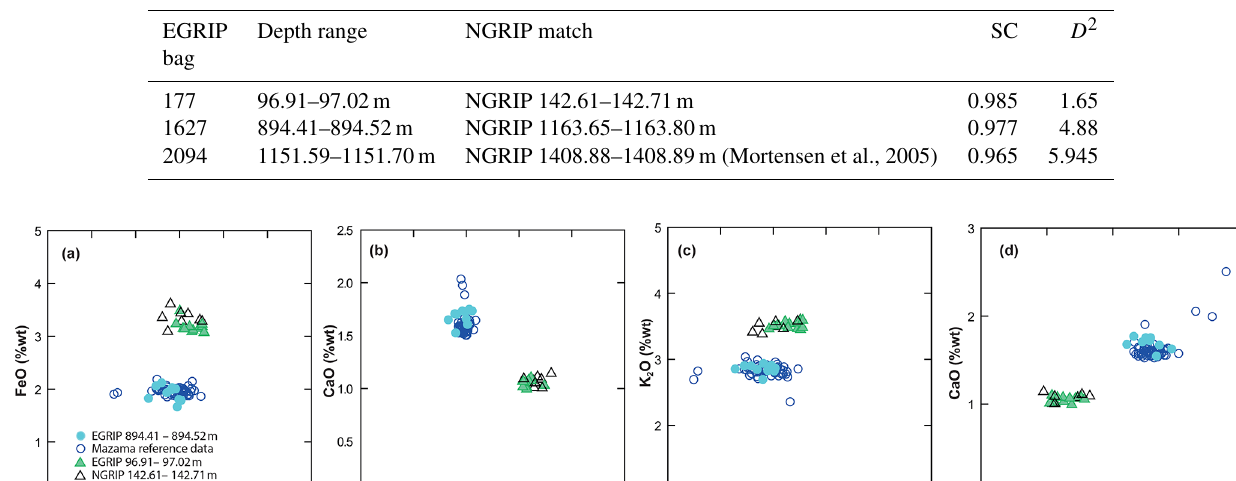
Table 1. Geochemical matches between EGRIP and NGRIP were supported by the similarity coefficient (SC) test of Borchardt et al. (1972) and statistical distance ( D 2 ) test of Perkins et al. (1995, 1998). Here, we provide SC and D 2 values for major elements (normalized to 100%) where five major elements (with > 1%wt) were used for SC calculations for sample pairs with rhyolitic composition and seven elements were used for sample pairs with basaltic composition. Values > 0 . 95 suggest products are from the same volcanic source. For D 2 , seven major elements were used for the comparisons (with > 0 . 01%wt). The value for testing the statistical distance values at the 99% confidence interval is 18.48 (7 degrees of freedom).